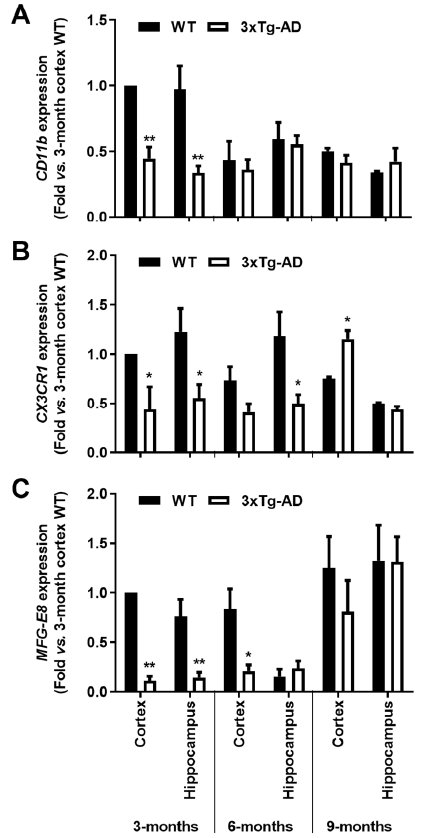
Figure 3. Microglial typical markers are decreased in the brain cortex and hippocampus of the 3-month-old 3xTg-AD mice. Samples from the wild-type (WT) and 3xTg-AD animals were collected at 3-, 6- and 9-month-old and analyzed for ( A ) CD11b , ( B ) CX3CR1 and ( C ) MFG-E8 mRNAs by RT-qPCR. Results are mean ± SEM, representative of n = 4 animals per experimental group, and are expressed as fold change vs. 3-month-old cortex WT mice. * p < 0.05 and ** p < 0.01 vs. respective WT, two-tailed Student’s t